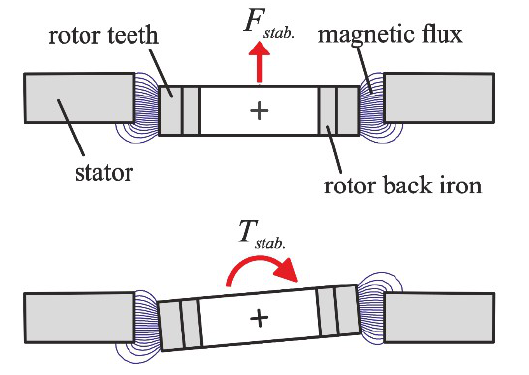
Figure 1. Passive stabilization for the axial ( top ) and tilting ( bottom ) deflection [7].